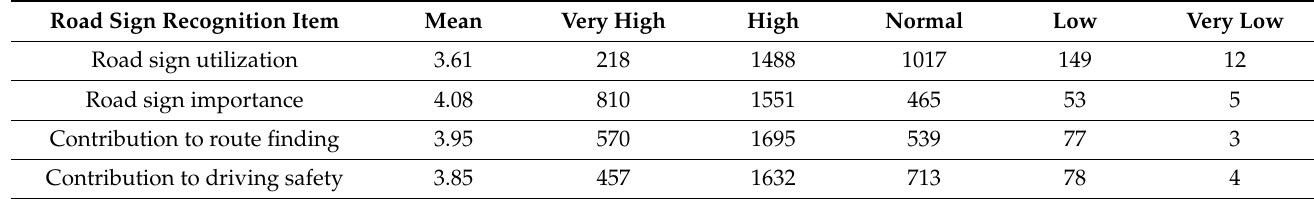
Table 4. Road sign recognition